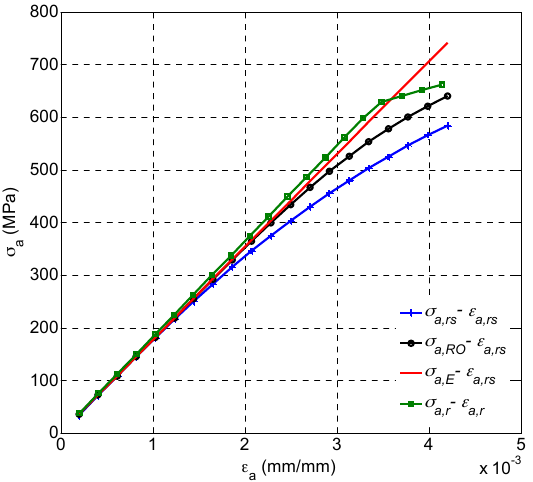
Figure 3. Four normal stress-strain curves on principle strain plane for GH4169 at 650 °C.